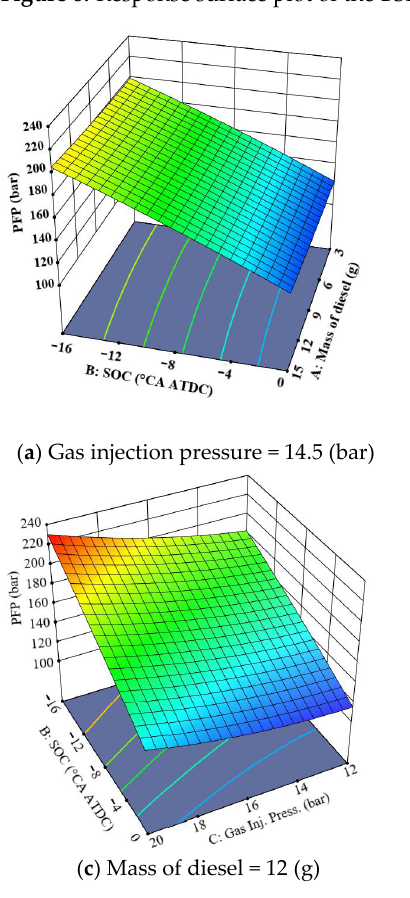
Figure 8. Response surface plot of the BSFC.